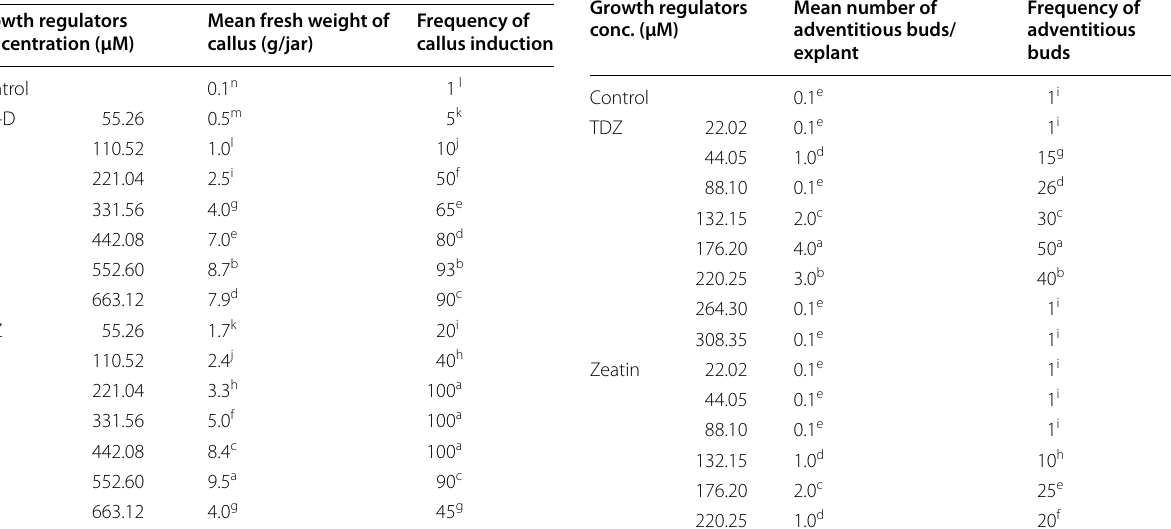
Table 4 Effect of TDZ and Zeatin on adventitious buds formation frequency and number of buds/callus